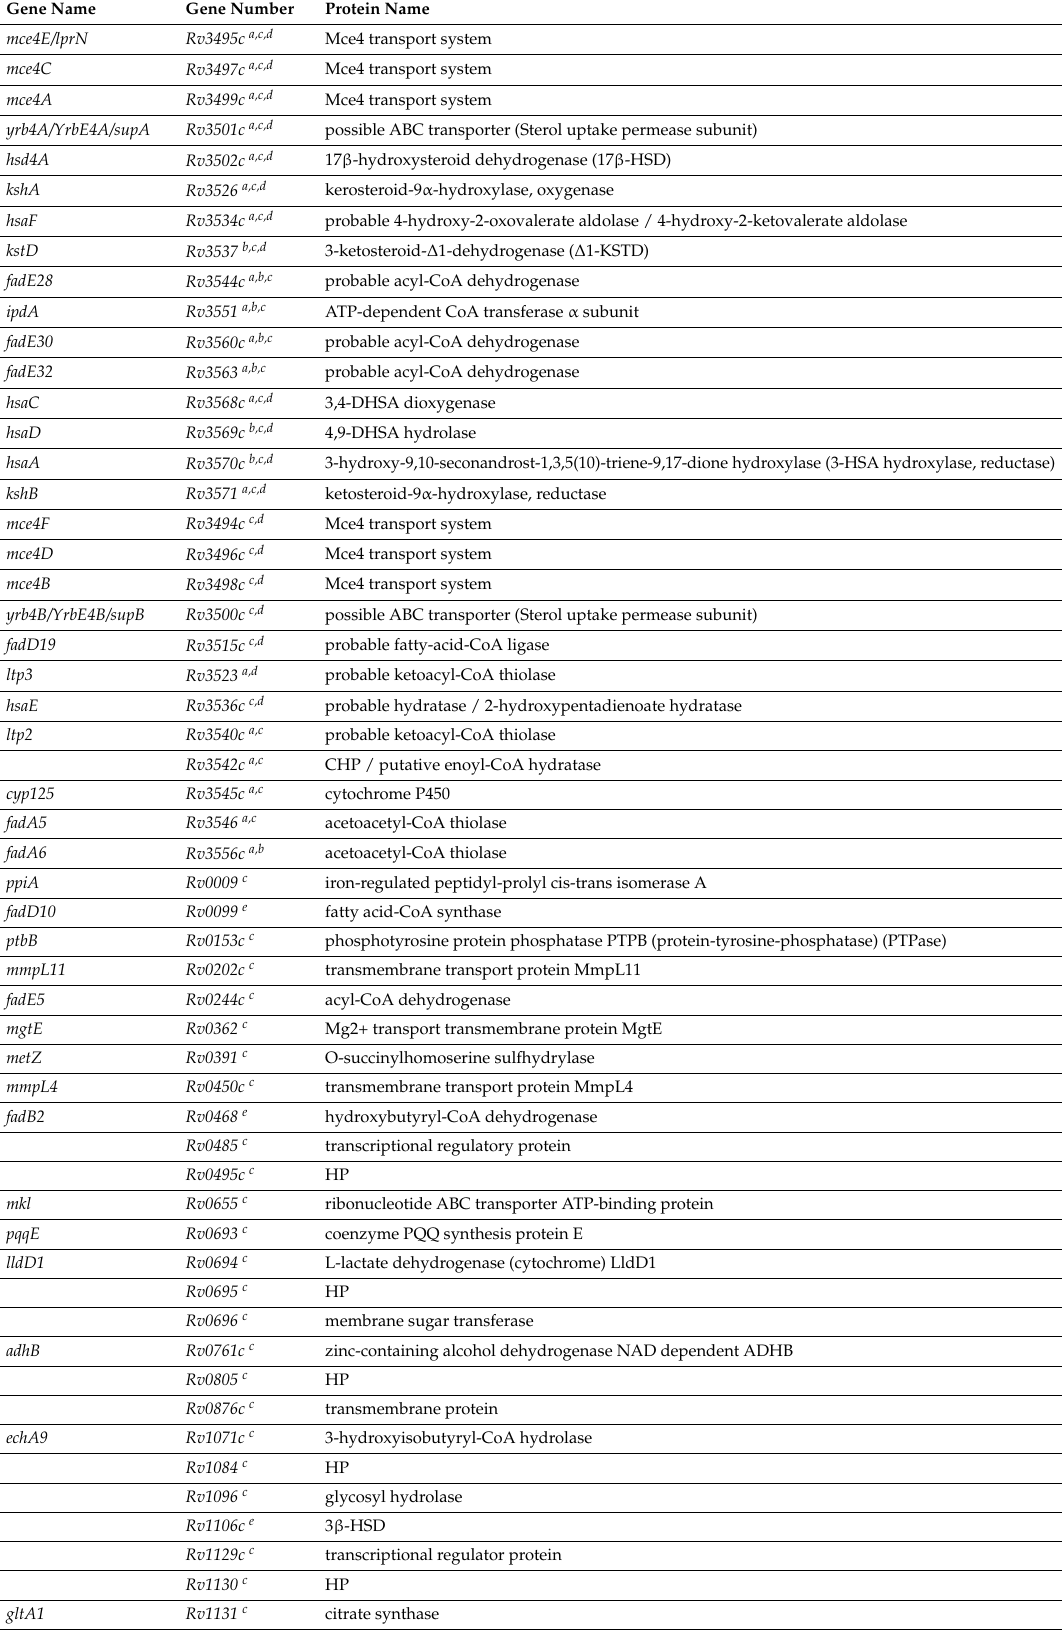
Table 1. List of genes/proteins selected for determining mycobacterial species’ ability to utilize cholesterol. A standalone set of genes representing different categories is presented in Tables